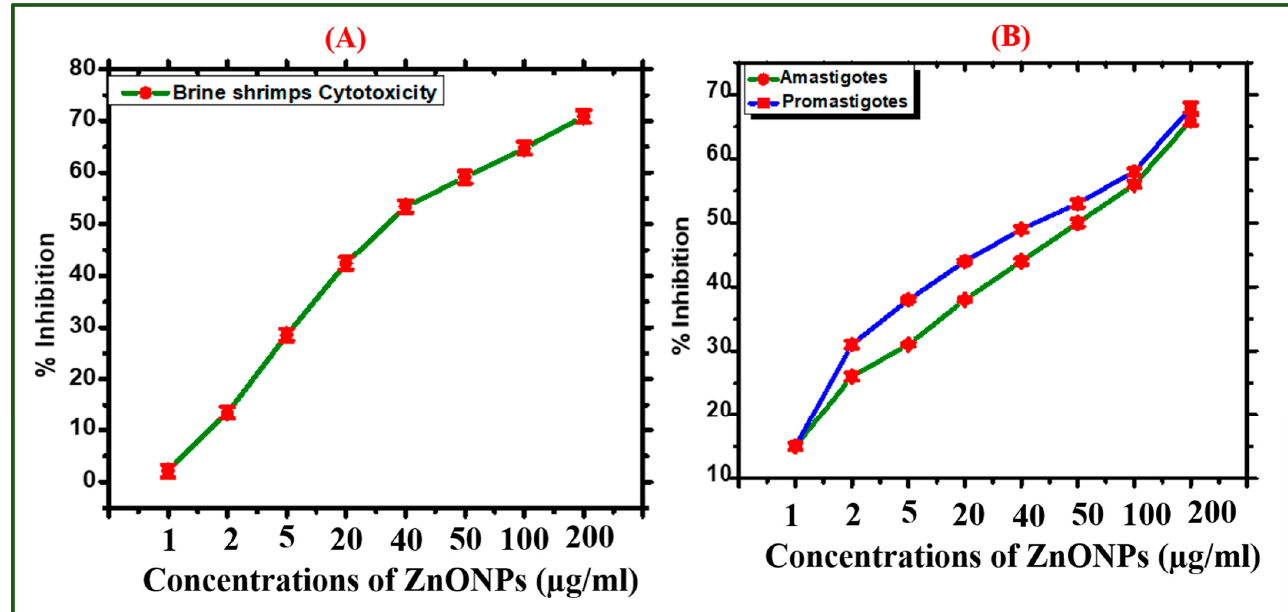
Figure 5. Analysis of cytotoxic activities. The data in these two figures represent the mean of three replications. ( A ) Cytotoxic capacity against brine shrimps; ( B ) antileishmanial activities of zinc oxide nanoparticles.